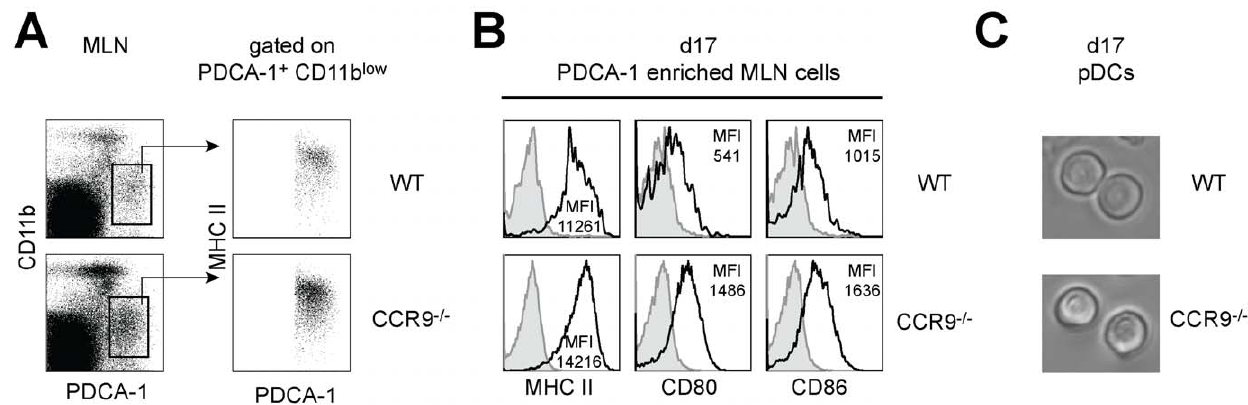
Figure 6. pDCs from CCR9 2 / 2 MLNs are more activated than WT pDCs. ( A ) pDCs of WT and CCR9 2 / 2 mice express low levels of CD11b in contrast to inflammatory macrophages. pDCs were defined as CD11b low MHC II int/high PDCA-1 + . ( B ) CCR9 2 / 2 pDCs show signs of phenotypic maturation. Maturation levels were assessed by comparing expression levels of MHC II and costimulatory molecules CD80 and CD86. ( C ) Morphology of pDCs isolated from WT and CCR9 2 / 2 animals.